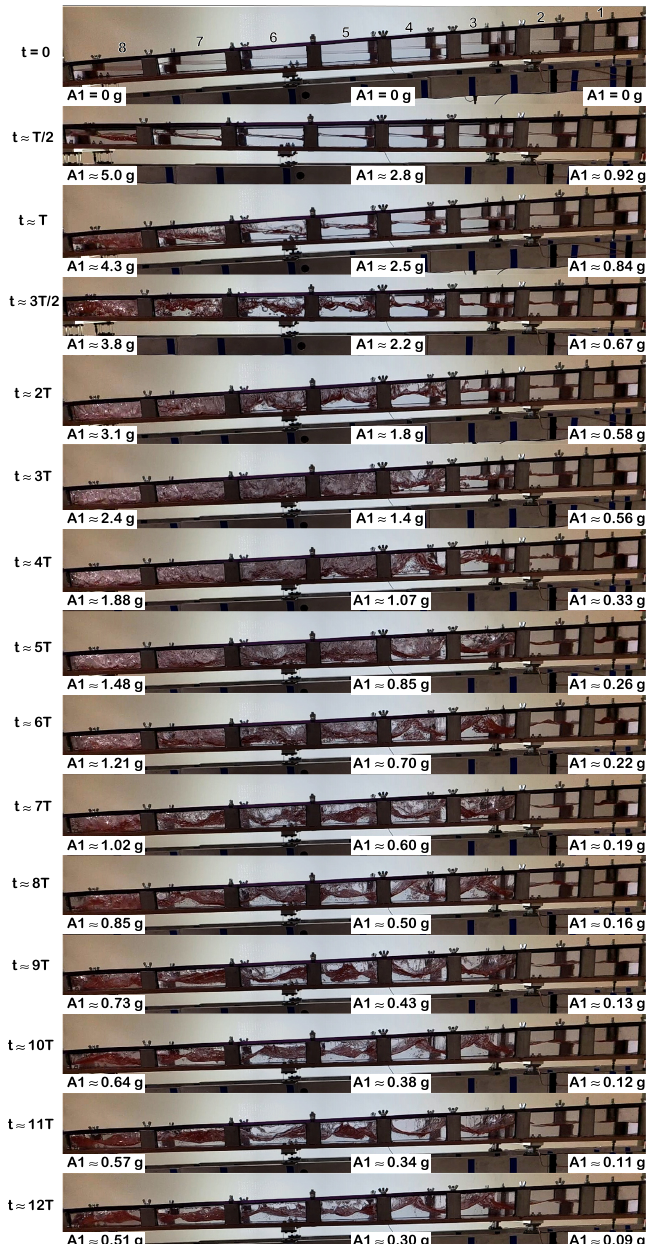
Figure 16. Selection of video segments for one representative 50% filling level test. Local acceleration for the first vibration component shown (left: tank